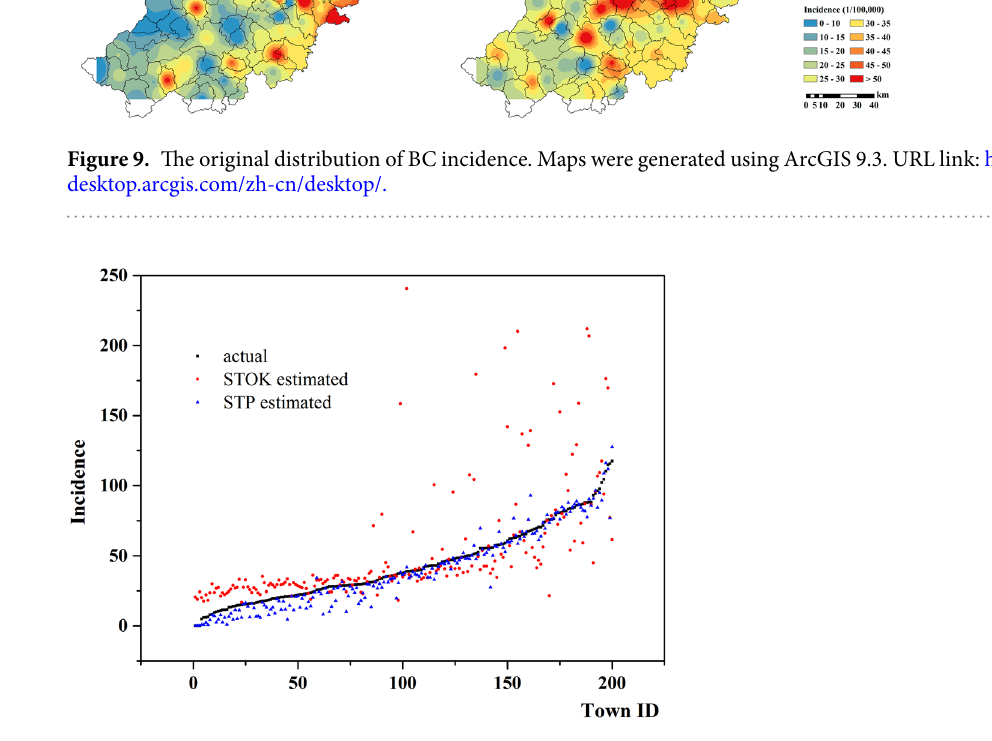
Figure 10. Plots of the 5-year averaged BC incidence at 1000 town points for the period 2008–2012: ( a ) actual BC incidence values (black points), ( b ) STOK estimated incidence values (red points), and ( c ) STP estimated incidence values (blue points). Incidence per 100,000